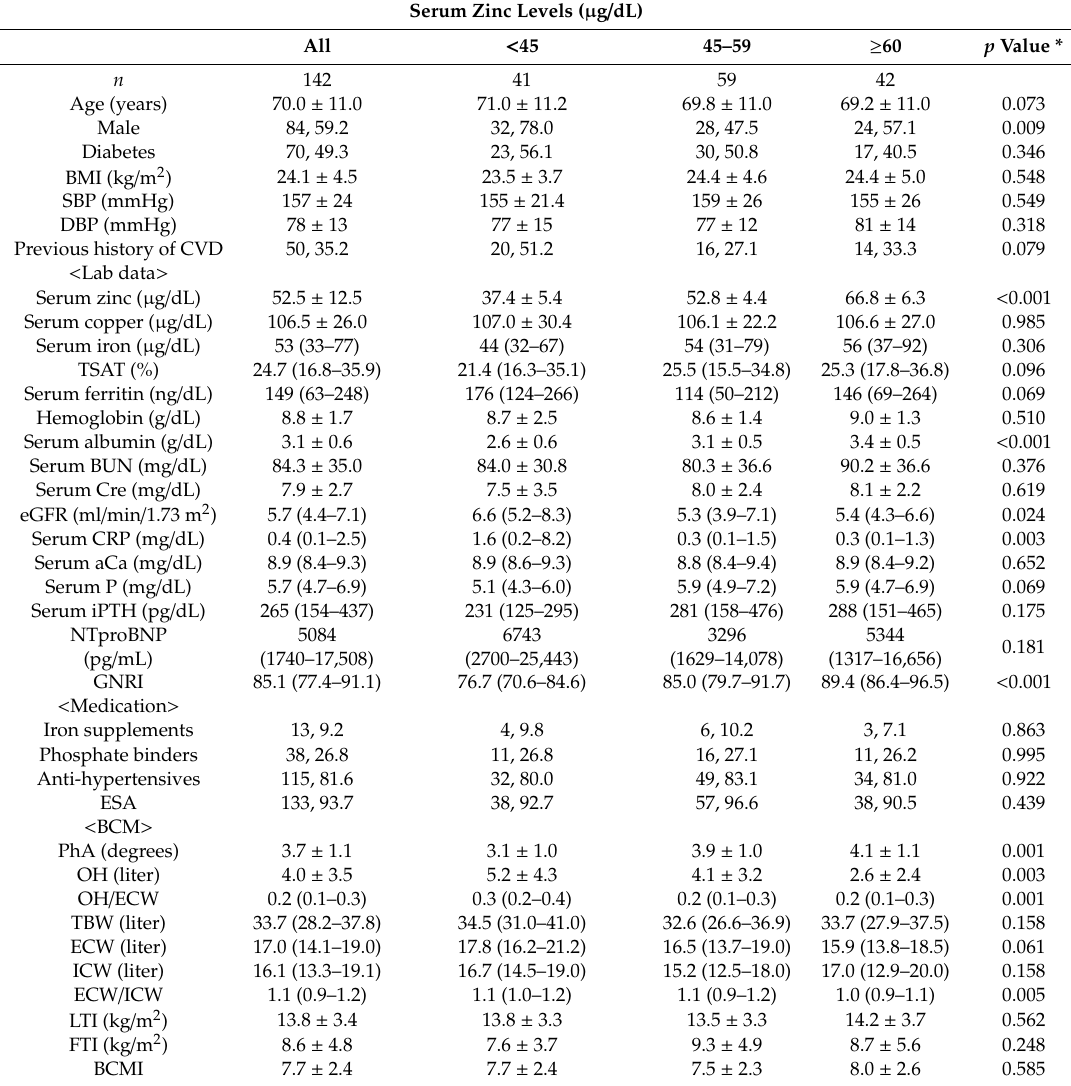
Table 1. Baseline